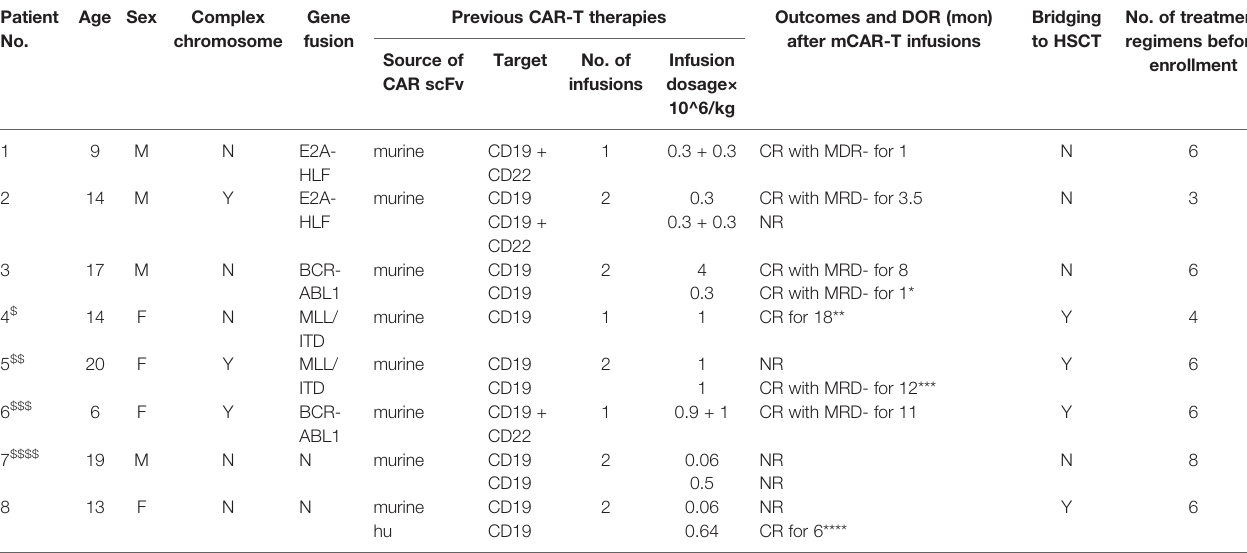
TABLE 1 | Patients ’ disease characteristics prior to CD19hs CAR-T infusion. Patient